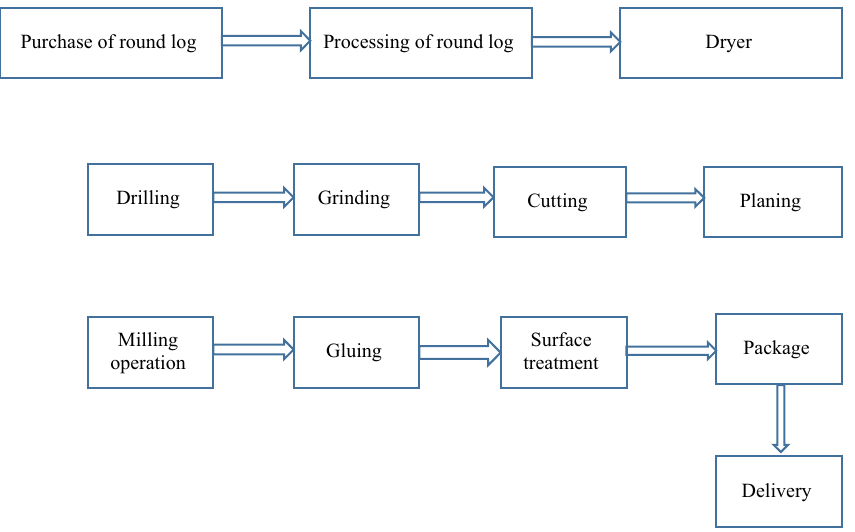
Figure 2: Production process ( scheme of the production process ) . Source: authors.